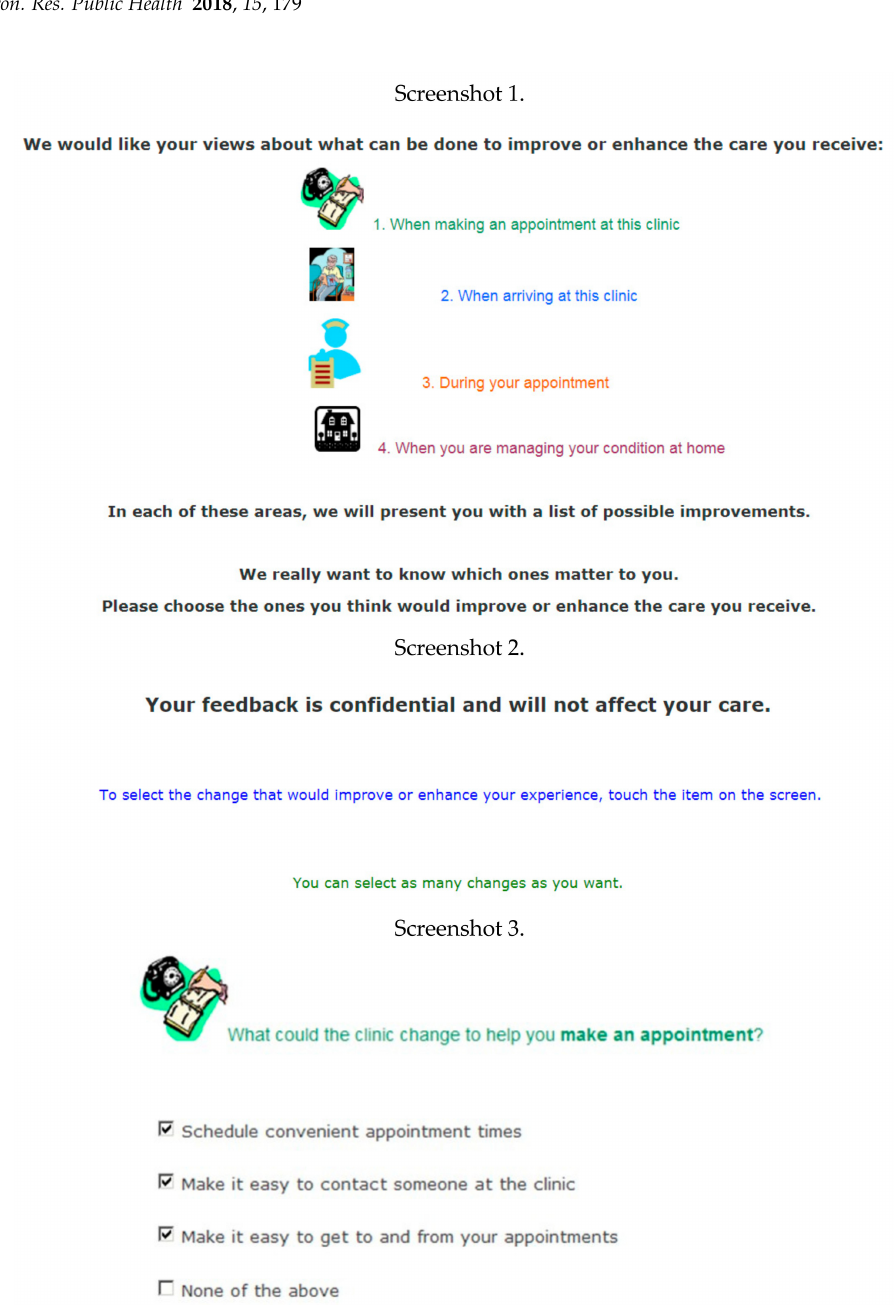
Figure 1. Screenshots of the Consumer-PS instructions and survey